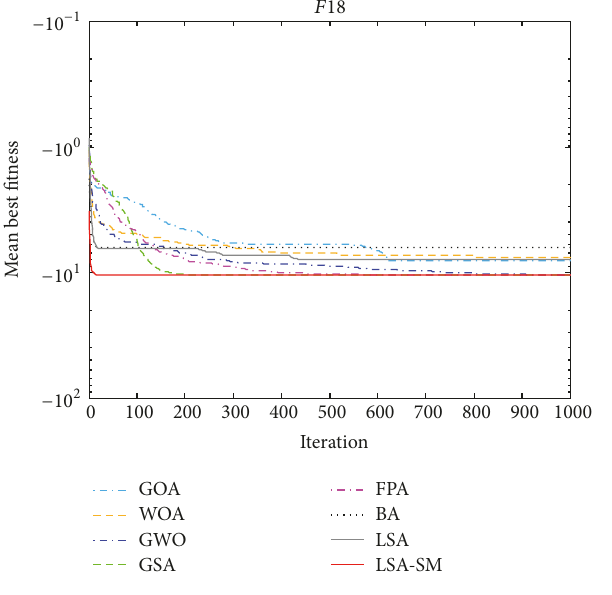
Figure 22: 𝐷 = 4 , convergence curves for 𝑓 18 .